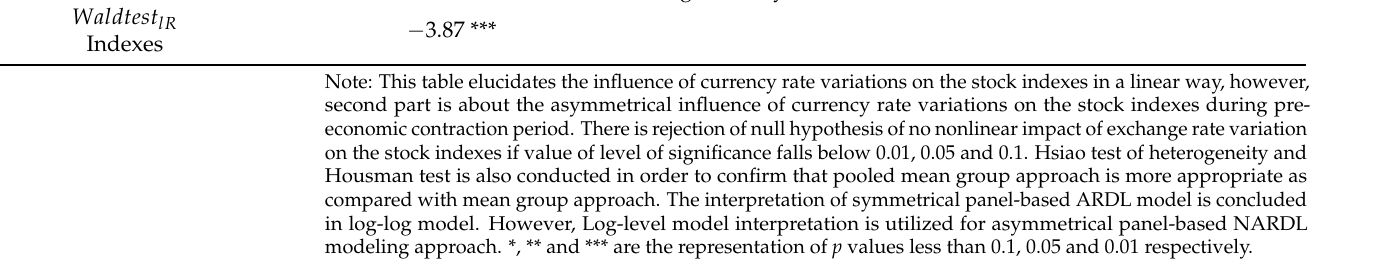
Table 7. Heterogeneous linear and nonlinear panel ARDL modeling approach with